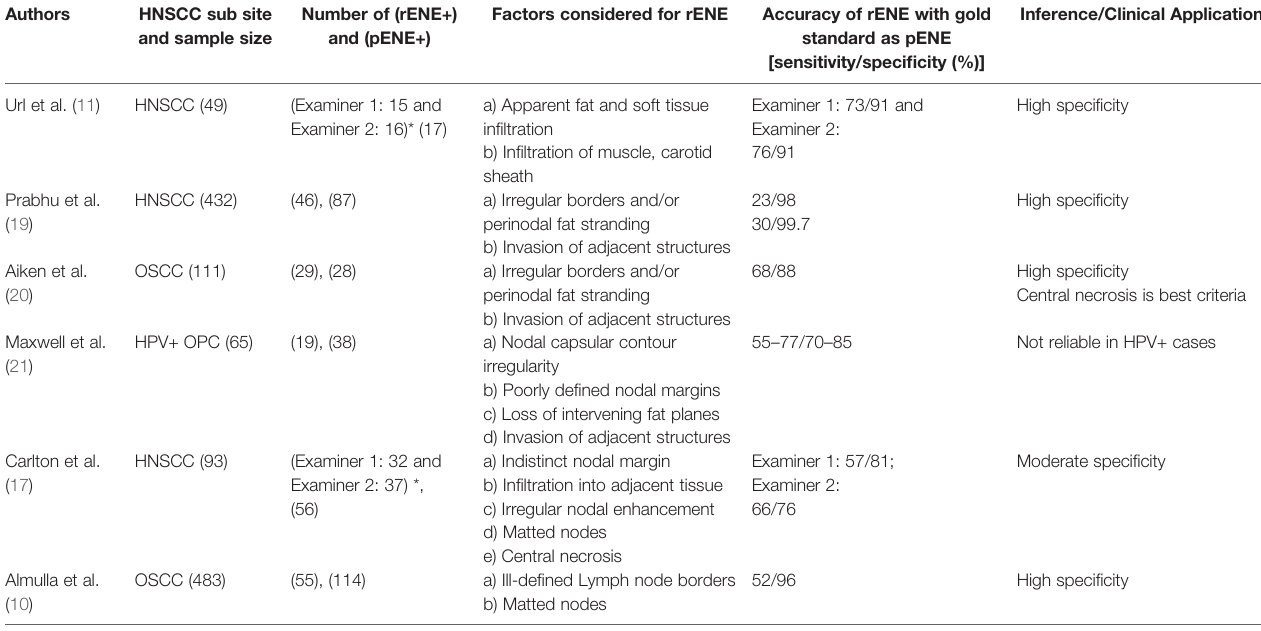
TABLE 7 | Systematic review of literature for diagnostic accuracy of imaging-based ENE versus pathological ENE as gold standard and its clinical implication.